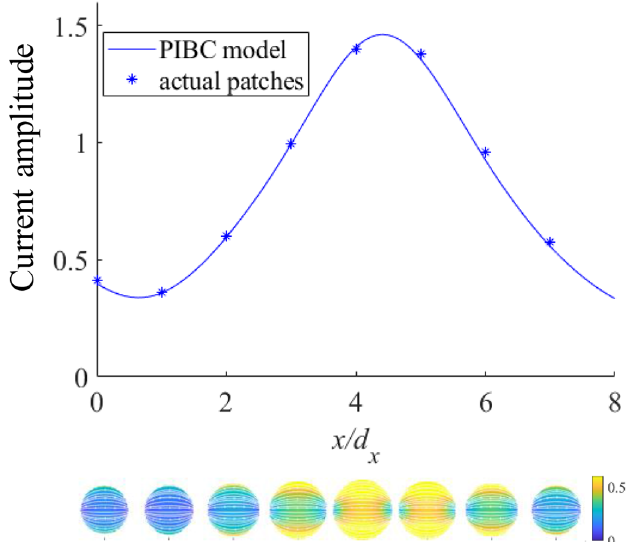
Fig. 7. Current amplitude on a modulated MTS: comparison between PIBC model and MoM. The color plot in the bottom shows the current on patches according to MoM solution.